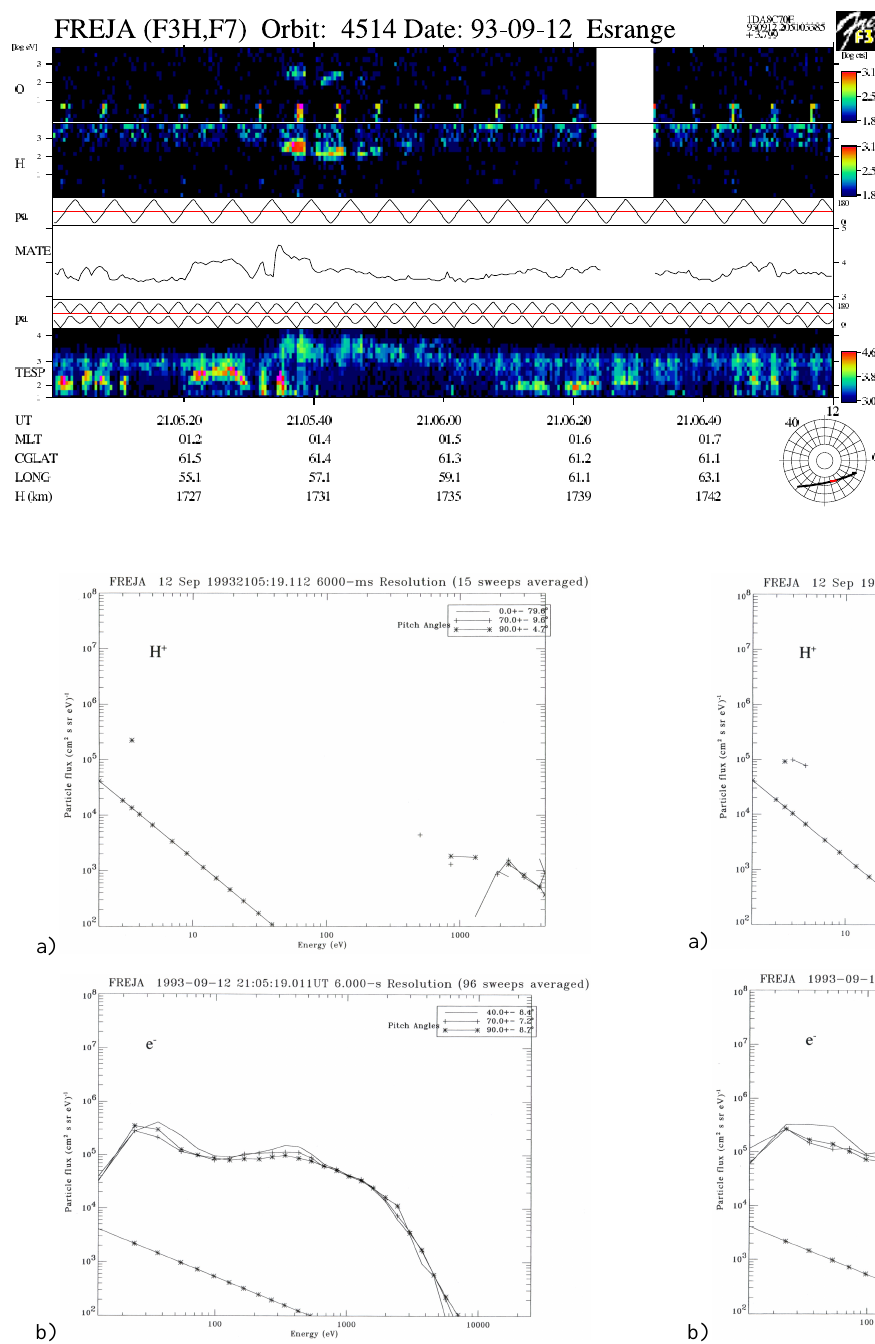
Fig.23. Measured energy spectra of H + ions (a) and electrons (b) near the time of peaking electron energies in Fig.21. Straight lines show 1-count